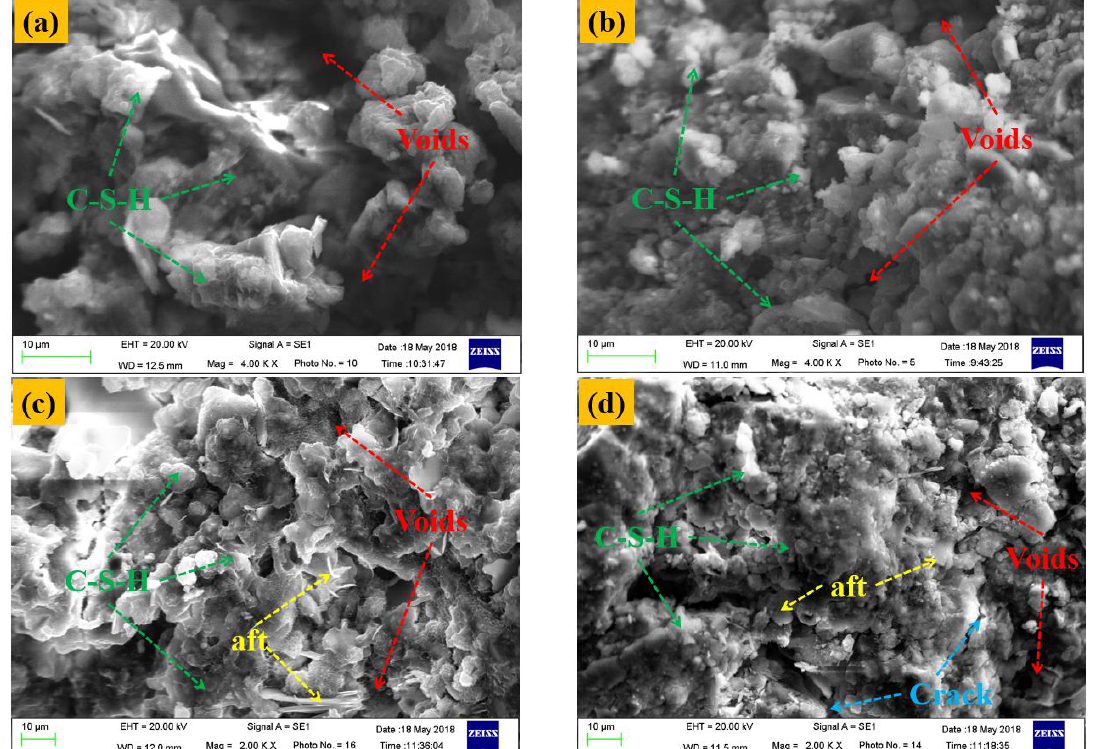
Figure 11. SEM micrographs of 28-day cured polished CTB surface: ( a ) SD: 65%; ( b ) SD: 68%; ( c ) SD: 70%; ( d ) SD: 72%.